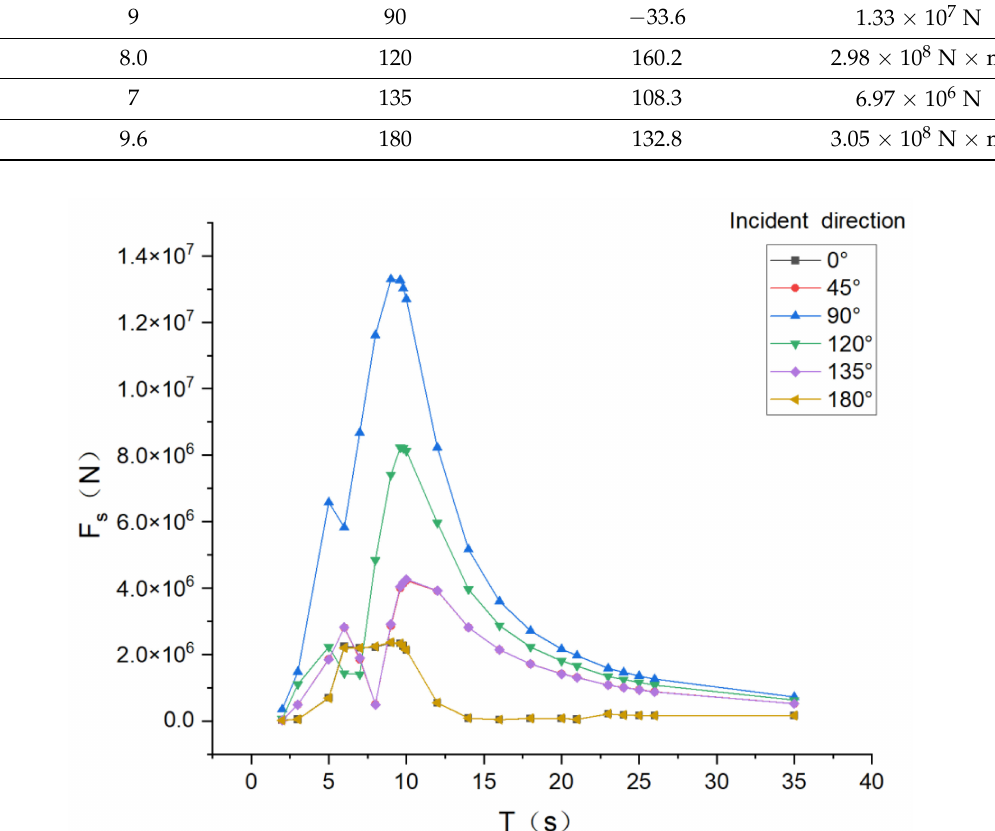
Figure 4. RAO of split